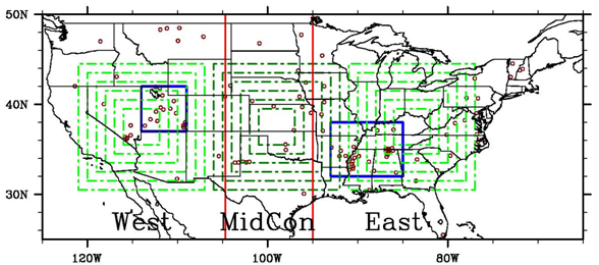
Fig. 1. SCAN site locations (in brown circles), climate regions (di- vided by red lines), sub-regions (in blue rectangles), and three series of concentric squares (in dark and light green) used in the scale- dependency study for Noah and AMSR-E soil moisture data.